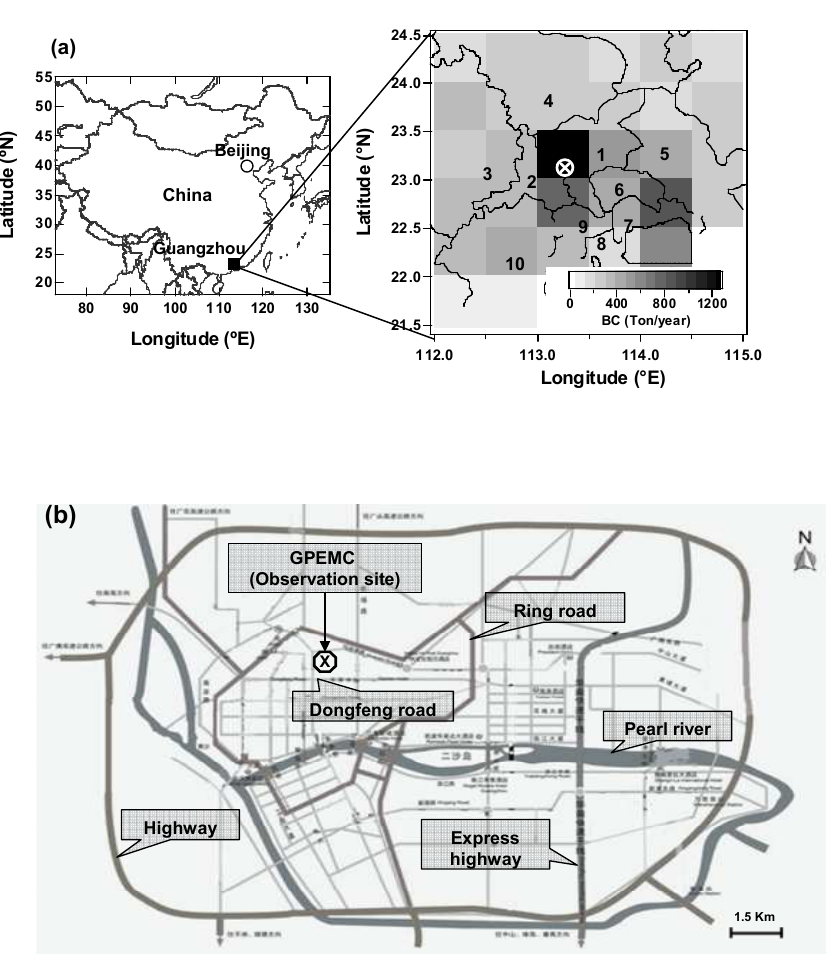
Fig. 1. (a) Spatial distribution of BC emissions (tons/year) in Guangzhou and surrounding areas (21.75 ◦ N–24.25 ◦ N, 112.25 ◦ E–114.75 ◦ E). Numeric labels are for: 1. Guangzhou, 2. Foshan, 3. Zhouqing, 4. Qianguan, 5. Huizhou, 6. Dongguan, 7. Shenzhen, 8. Zhuhai, 9. Zhongshan, and 10. Jiangmen. The white circled cross represents the observation site. (b) Road network surrounding the observation site in